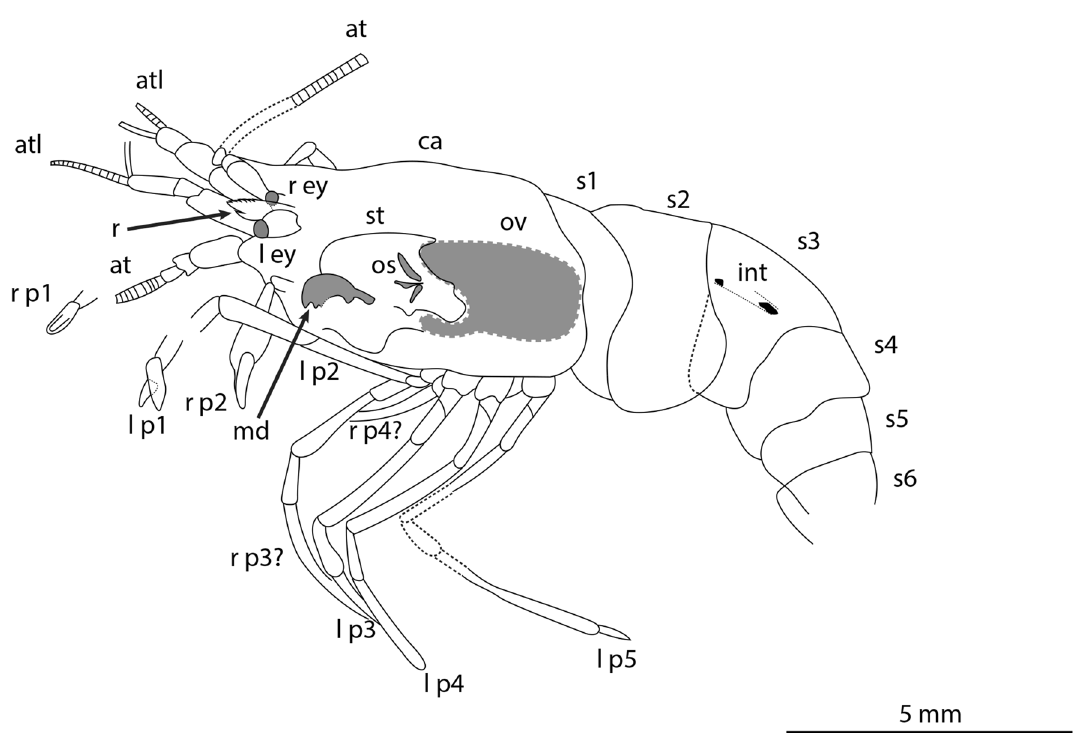
Figure 3. Interpretative drawing of the holotype of Bechleja brevirostris n. sp. based on both sides of the fossil (SF-MeI 5933 A and B). atl, antennules; at, antenna; r, rostrum; r ey, right eye; l ey, left eye; ca, carapace; r p1, right first pereiopod; l p1, left first pereiopod; r p2, right second pereiopod; r p3, right third pereiopod; l p3, left third pereiopod; r p4, right fourth pereiopod; l p4, left fourth pereiopod; l p5, left fifth pereiopod; md, left mandible; st, stomach; os, gastric ossicles; ov, ovary; int, intestine; s1, first abdominal somite; s2 second abdominal somite; s3, third abdominal somite; s4, fourth abdominal somite; s5, fifth abdominal somite; s6, sixth abdominal